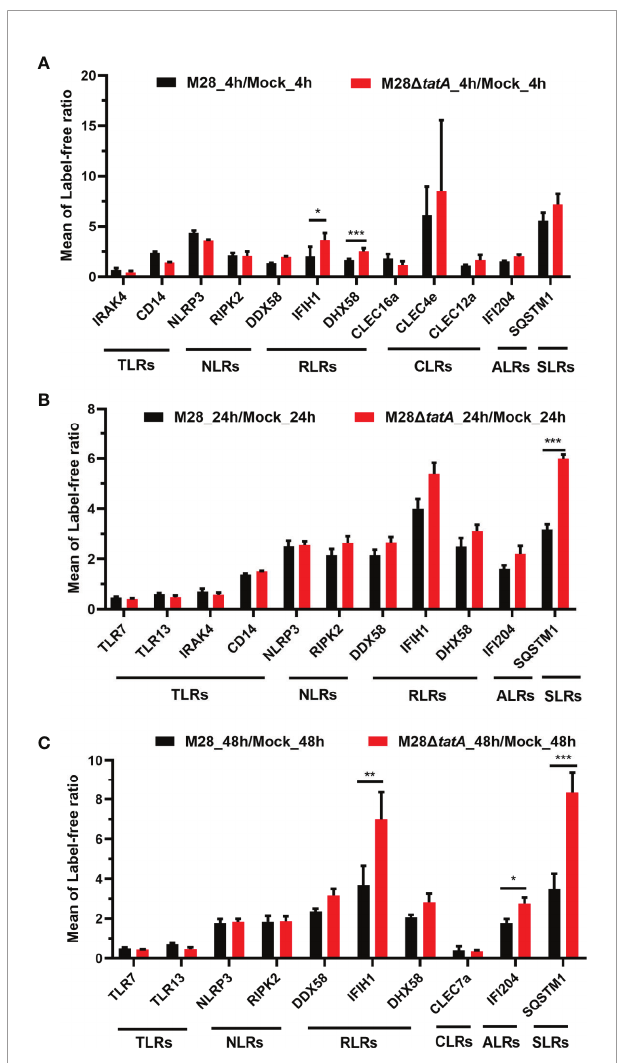
FIGURE 3 | Regulation of proteins associated with pattern recognition receptors in RAW264.7 cells after infection with M28 and M28 D tatA at 4 hpi (A) , 24 hpi (B) and 48 hpi (C) . Student ’ s t test was used to evaluate signi fi cant differences between the M28 D tatA mutant and the wild type. *p < 0.05; **p < 0.01; ***p <